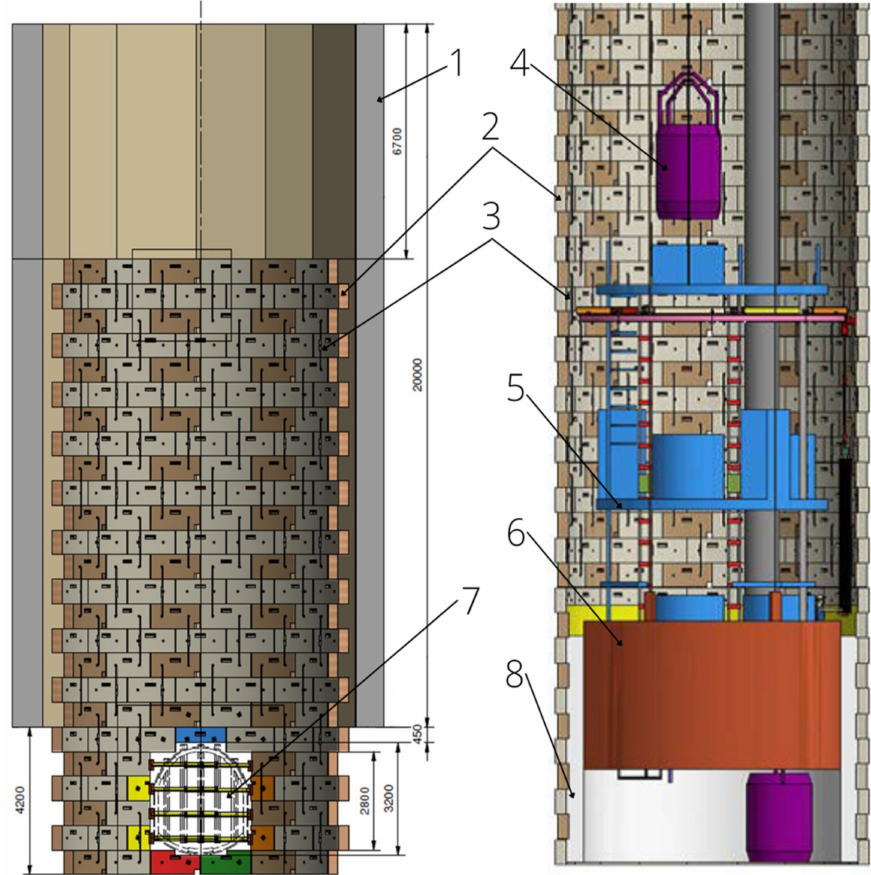
Figure 9. Layout of the shaft lining: 1—diagram wall, 2 –concrete panel (grey—standard panel; brown—panel with gaps for concreting; yellow, blue, red, green, orange—special construction panel), 3—panel fasteners, 4—sinking bucket, 5—suspended stage, 6—steel formwork, 7—inlet of backfill pipeline channel, 8—final concrete